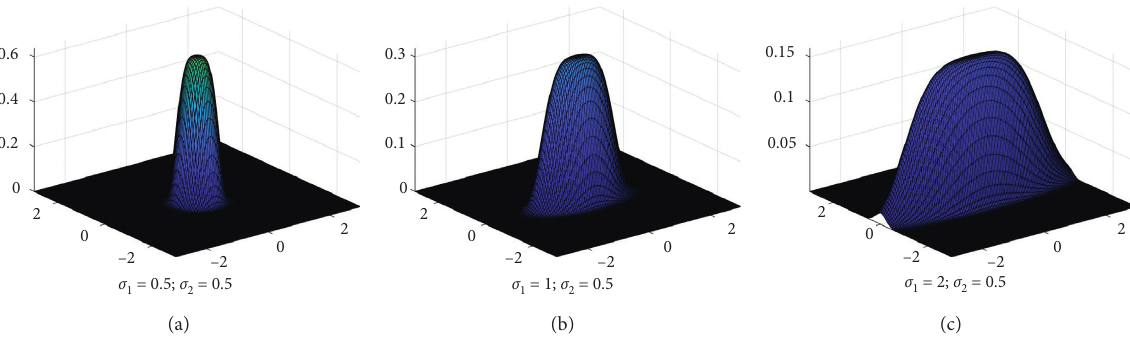
Figure 8: Three-dimensional images of Gaussian kernels with different σ